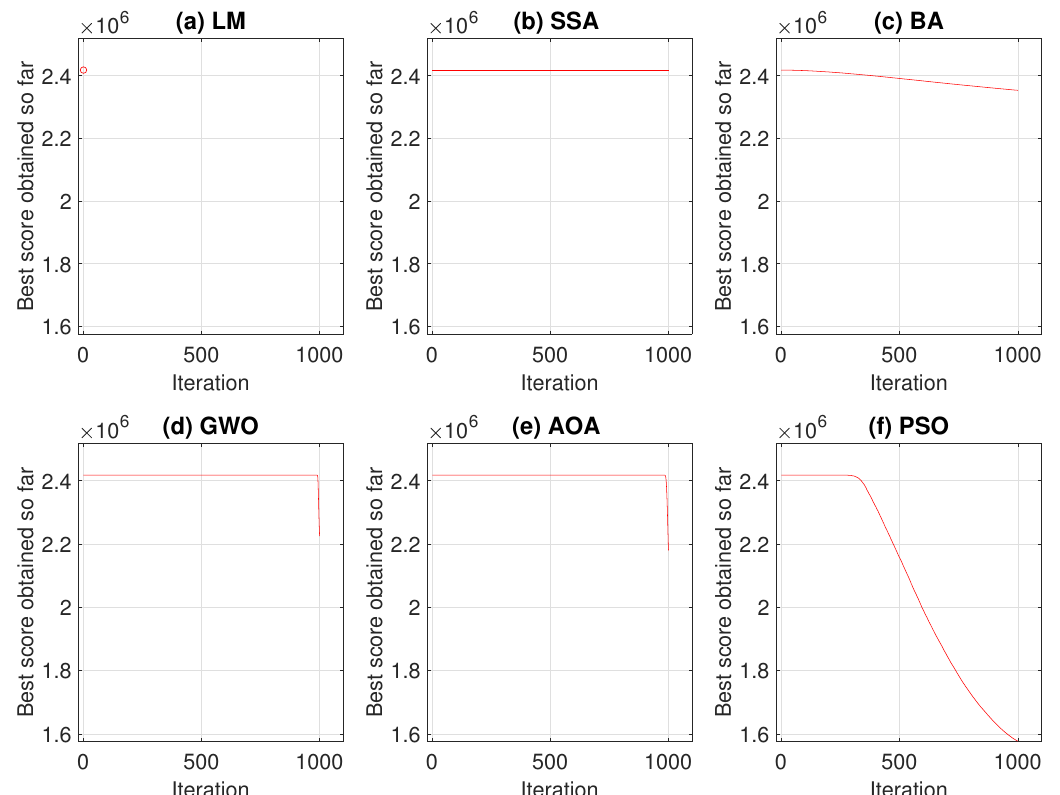
Figure 12. Convergence Curves in 250 simulations for Case Study II.